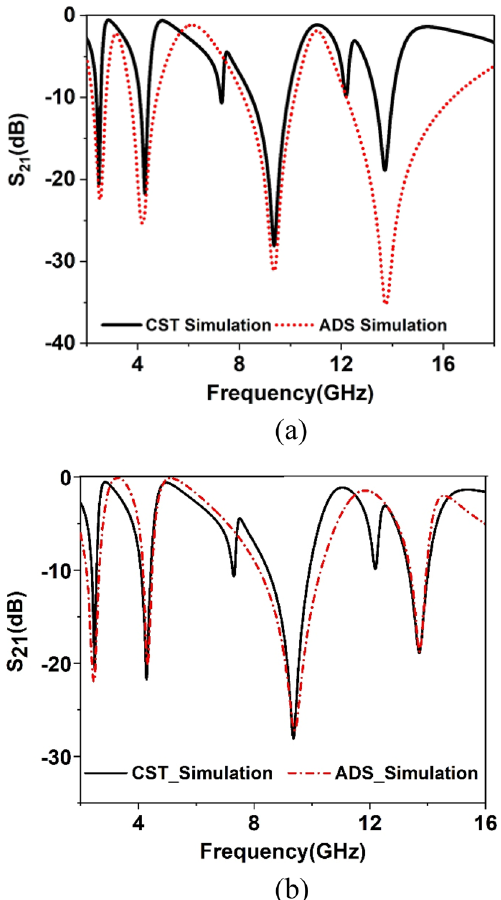
Figure 15. ( a ) Comparison of S 21 where ADS output obtained for primary equivalent circuit of Fig. 14a. ( b ) Comparison of S 21 where ADS output obtained for modified equivalent circuit of Fig. 14b.